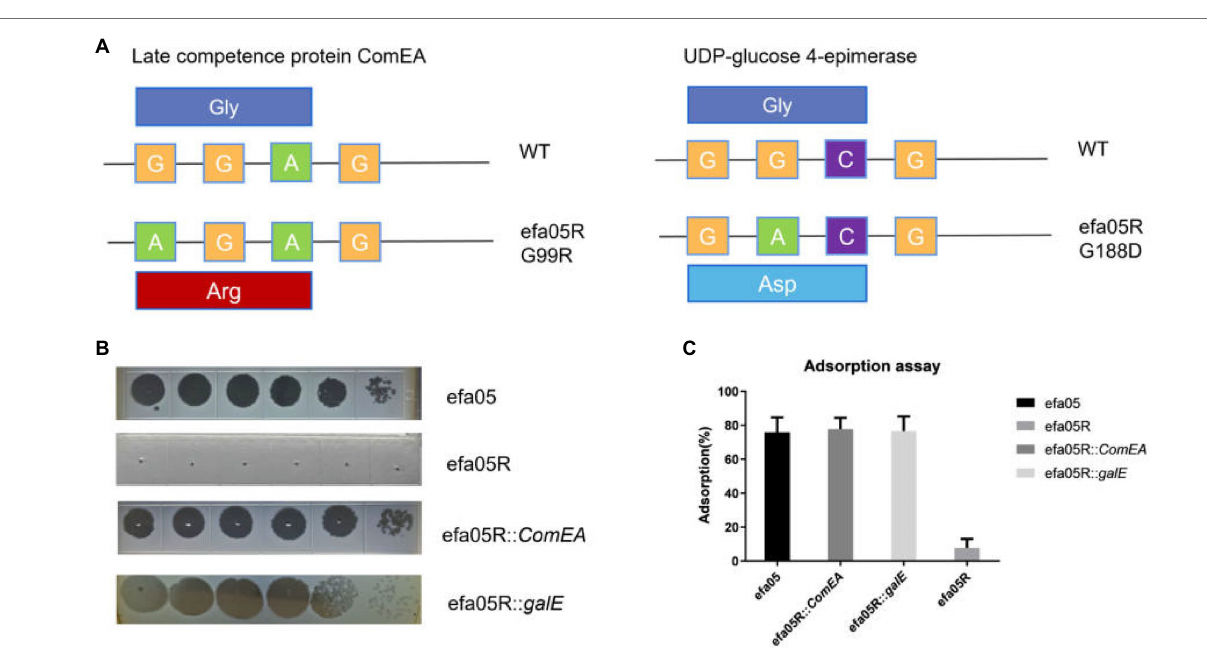
FIGURE 4 | Characterization of the phage-resistant mutant. (A) The mutation site in efa05R was detected as G99R in ComEA and G188D in galE . (B) The EOP experiment of phage against wild type strain, phage resistant efa05R, and the complemented strains. (C) Adsorption assay of phage onto each